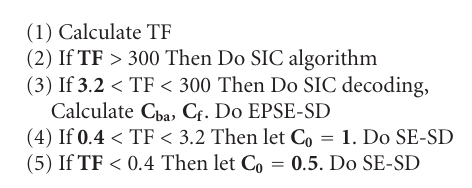
Algorithm 1: TF-Based